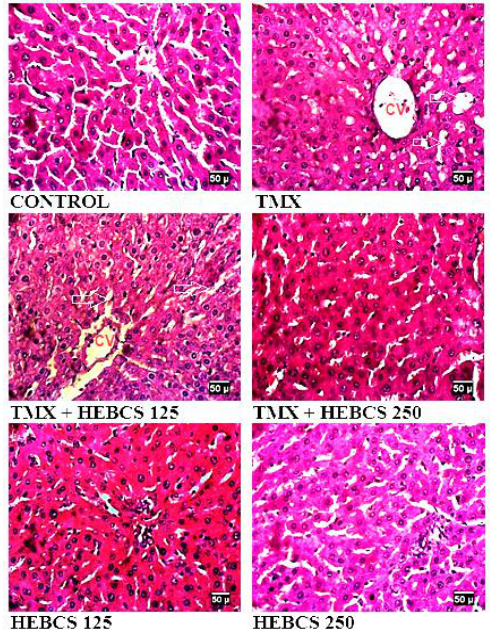
Figure 12. Representative images (×400) of hematoxylin and eosin stained formalin-fixed paraffin- embedded liver sections showing the effects of HEBCS and TMX on hepatic structures. CV: central vein; TMX: Tamoxifen; HEBCS 125 and 250: Hydroethanolic Extract of Buchholzia coriacea Seeds, 125 and 250 mg/kg body weight.